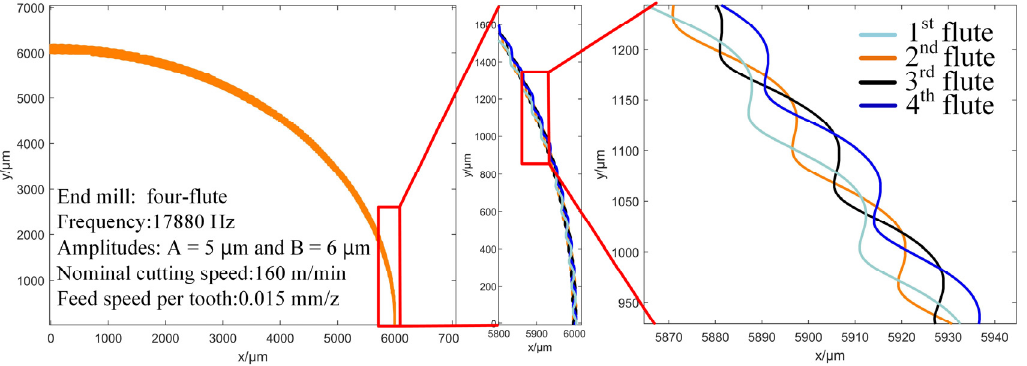
Figure 2. Trajectories of the tool tips in HRUEM.